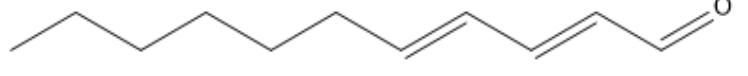
Figure 1. Structure of trans, trans -2,4-undecadienal.